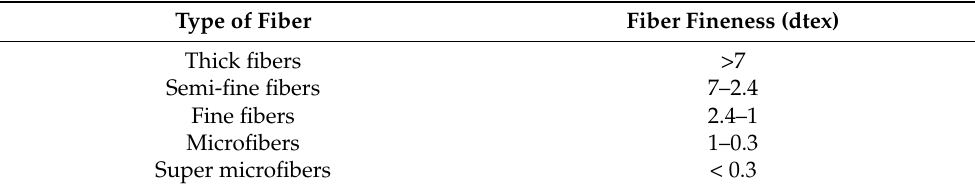
Table 2. Fineness classification of